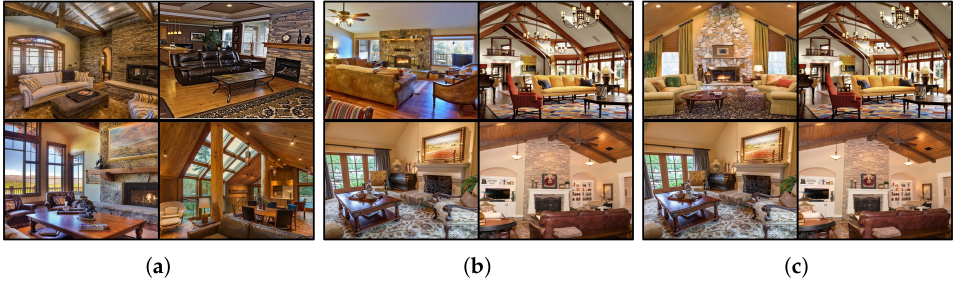
Figure 8. Examples of images estimated as rustic. ( a ) Image labeled as rustic style. ( b ) Image labeled as traditional style for ResNet. ( c ) Image labeled as traditional style for the proposed